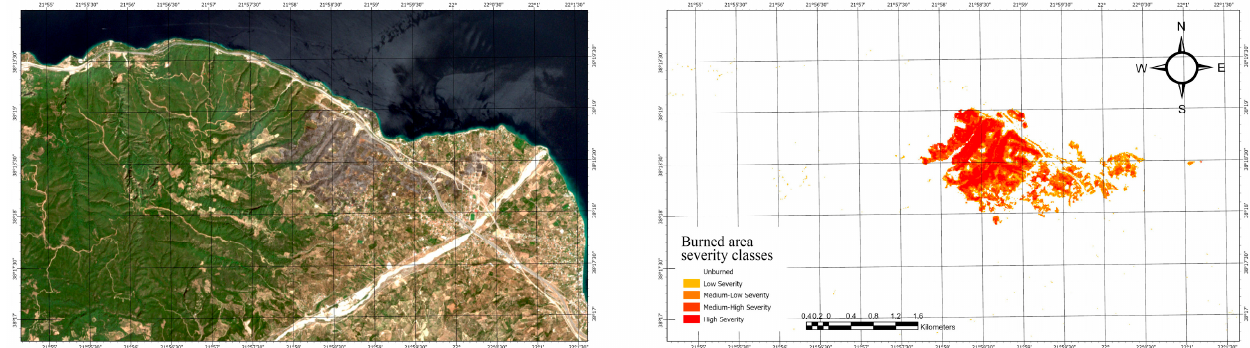
Figure 7. RGB true color representation (using Sentinel-2 bands) of the wider area of Aigialeia, Greece ( left ), and the burned area classified into 4 severity classes ( right ).